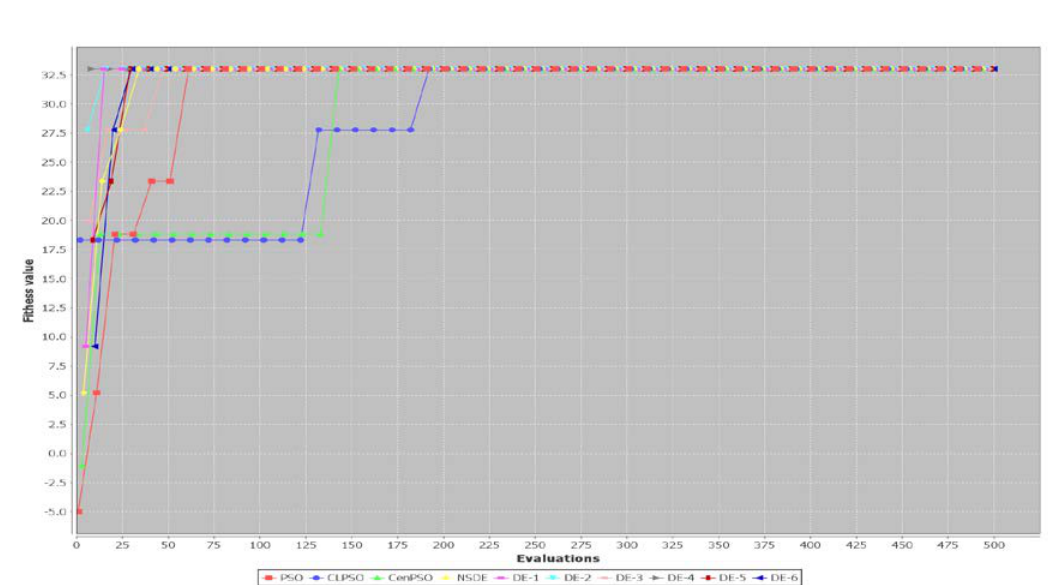
Figure A1. Convergence speed of a run of each algorithm for Case 1 with POP = 30.